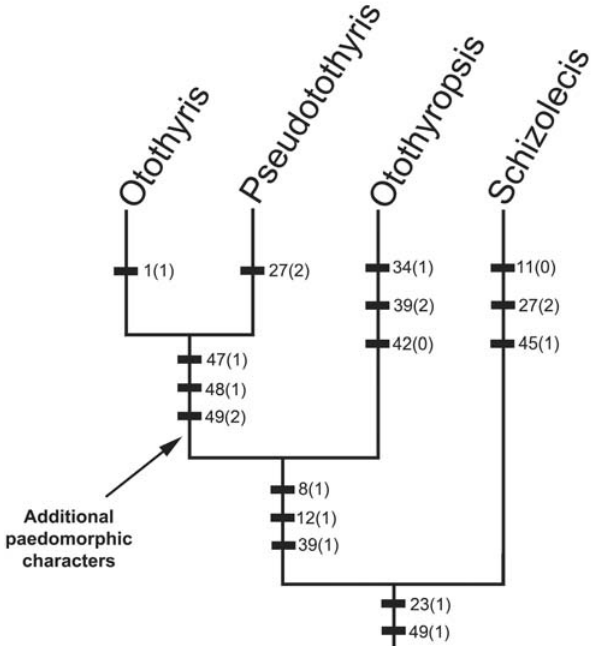
Fig. 10. Phylogenetic relationships of Otothyropsis mara- poama . Characters states supporting nodes are unambigu- ous characters published by Schaefer (1998), except for char- acters 47, 48 and 49, included in our reanalysis. Paedomor- phic characters commented in the text represent putative ad- ditional synapomorphies of Otothyris and Pseudotothyris